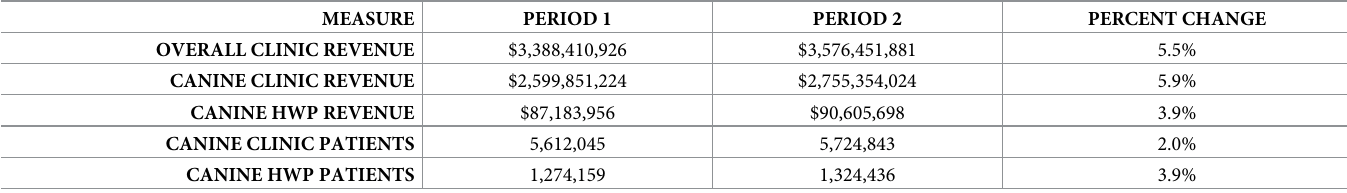
Table 9. All practice revenue comparison Period 1 vs Period 2. Non-PH users.